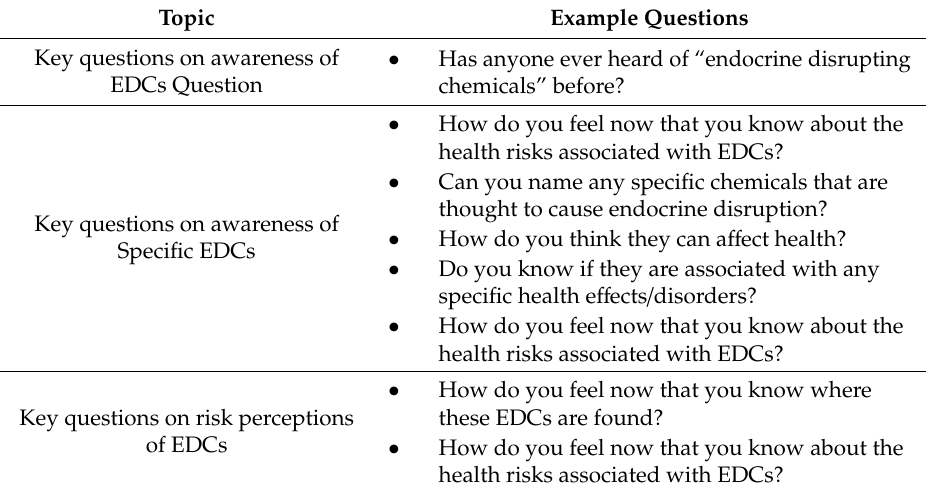
Table 2. Outline of Focus Group Topic Guide. EDC: endocrine disrupting